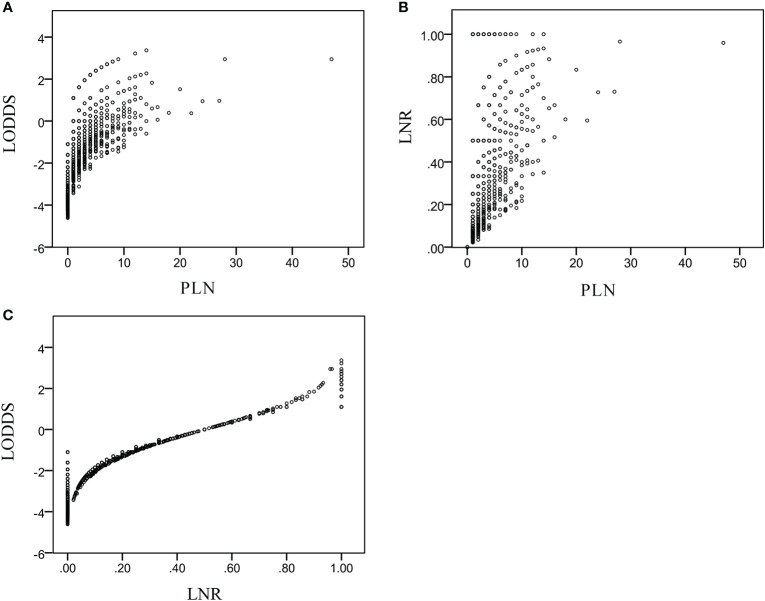
Distribution characteristics of LODDS and PLN (A), LNR and PLN (B), LODDS and LNR (C).